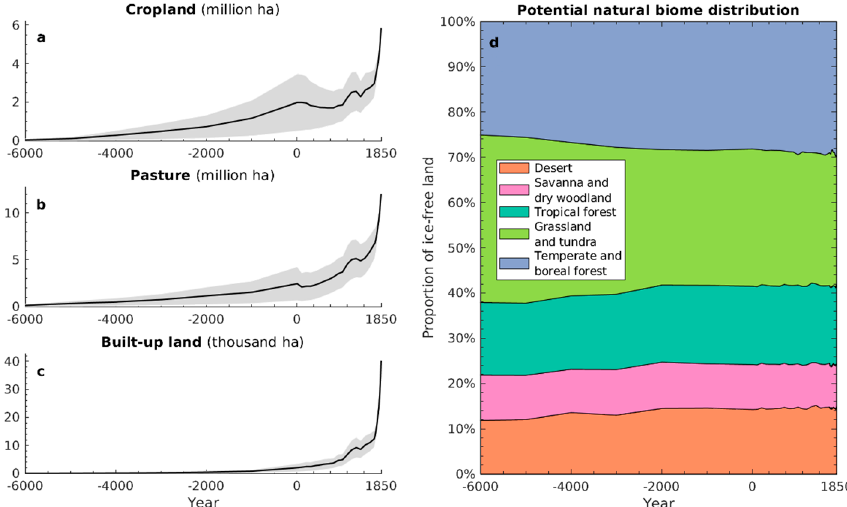
Figure 1. Global anthropogenic land use and potential natural vegetation between 6000 BCE and 1850 CE. ( a – c ) Total area of cropland, pasture, and built-up land. Grey bands represent uncertainty bounds. ( d ) Distribution of megabiomes (aggregated from the original 29 biomes simulated by Biome4, for visual clarity).